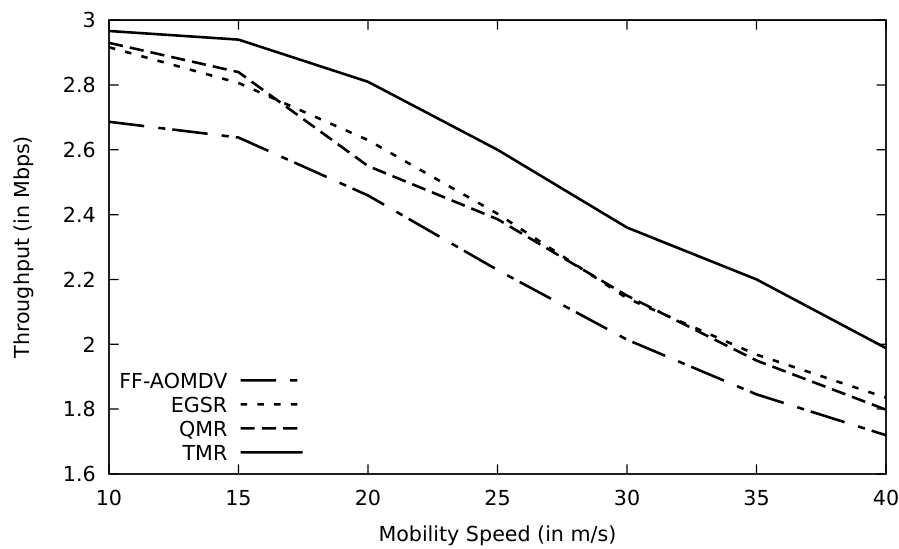
Figure 18. Comparison of AOMDV, FF-AOMDV, EGSR, QMR, and proposed protocol TMR for throughput with mobility speed.